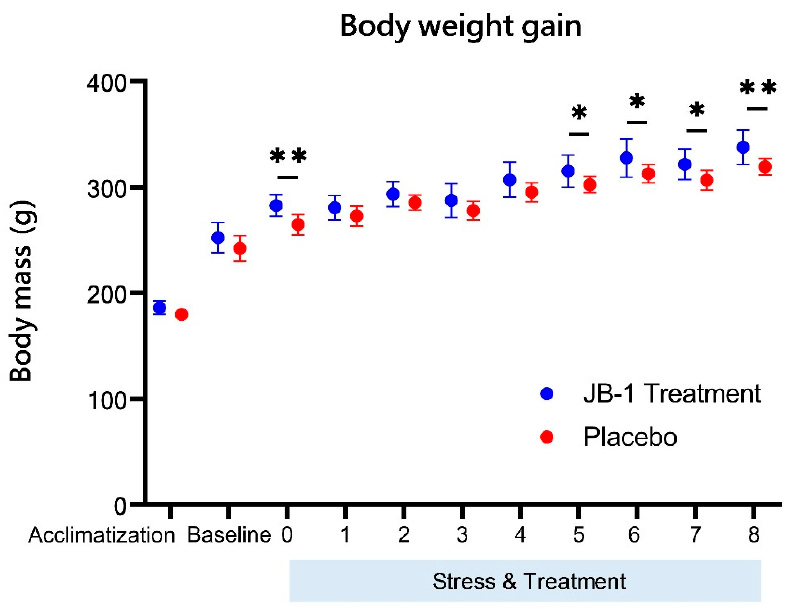
Figure 1. Rats body weight measured at the start of acclimatization, at baseline (before first MRI + MRS scanning), at week 0 (the start point of stress and feeding, after one week of MRI + MRS scan- ning) and every week during the stress protocol and the administration of JB-1 (N = 10) or placebo (N = 9). Data are represented as means ± SD. * p < 0.05; ** p < 0.01, two-way ANOVA analysis for repeated measures with post-hoc Duncan’s